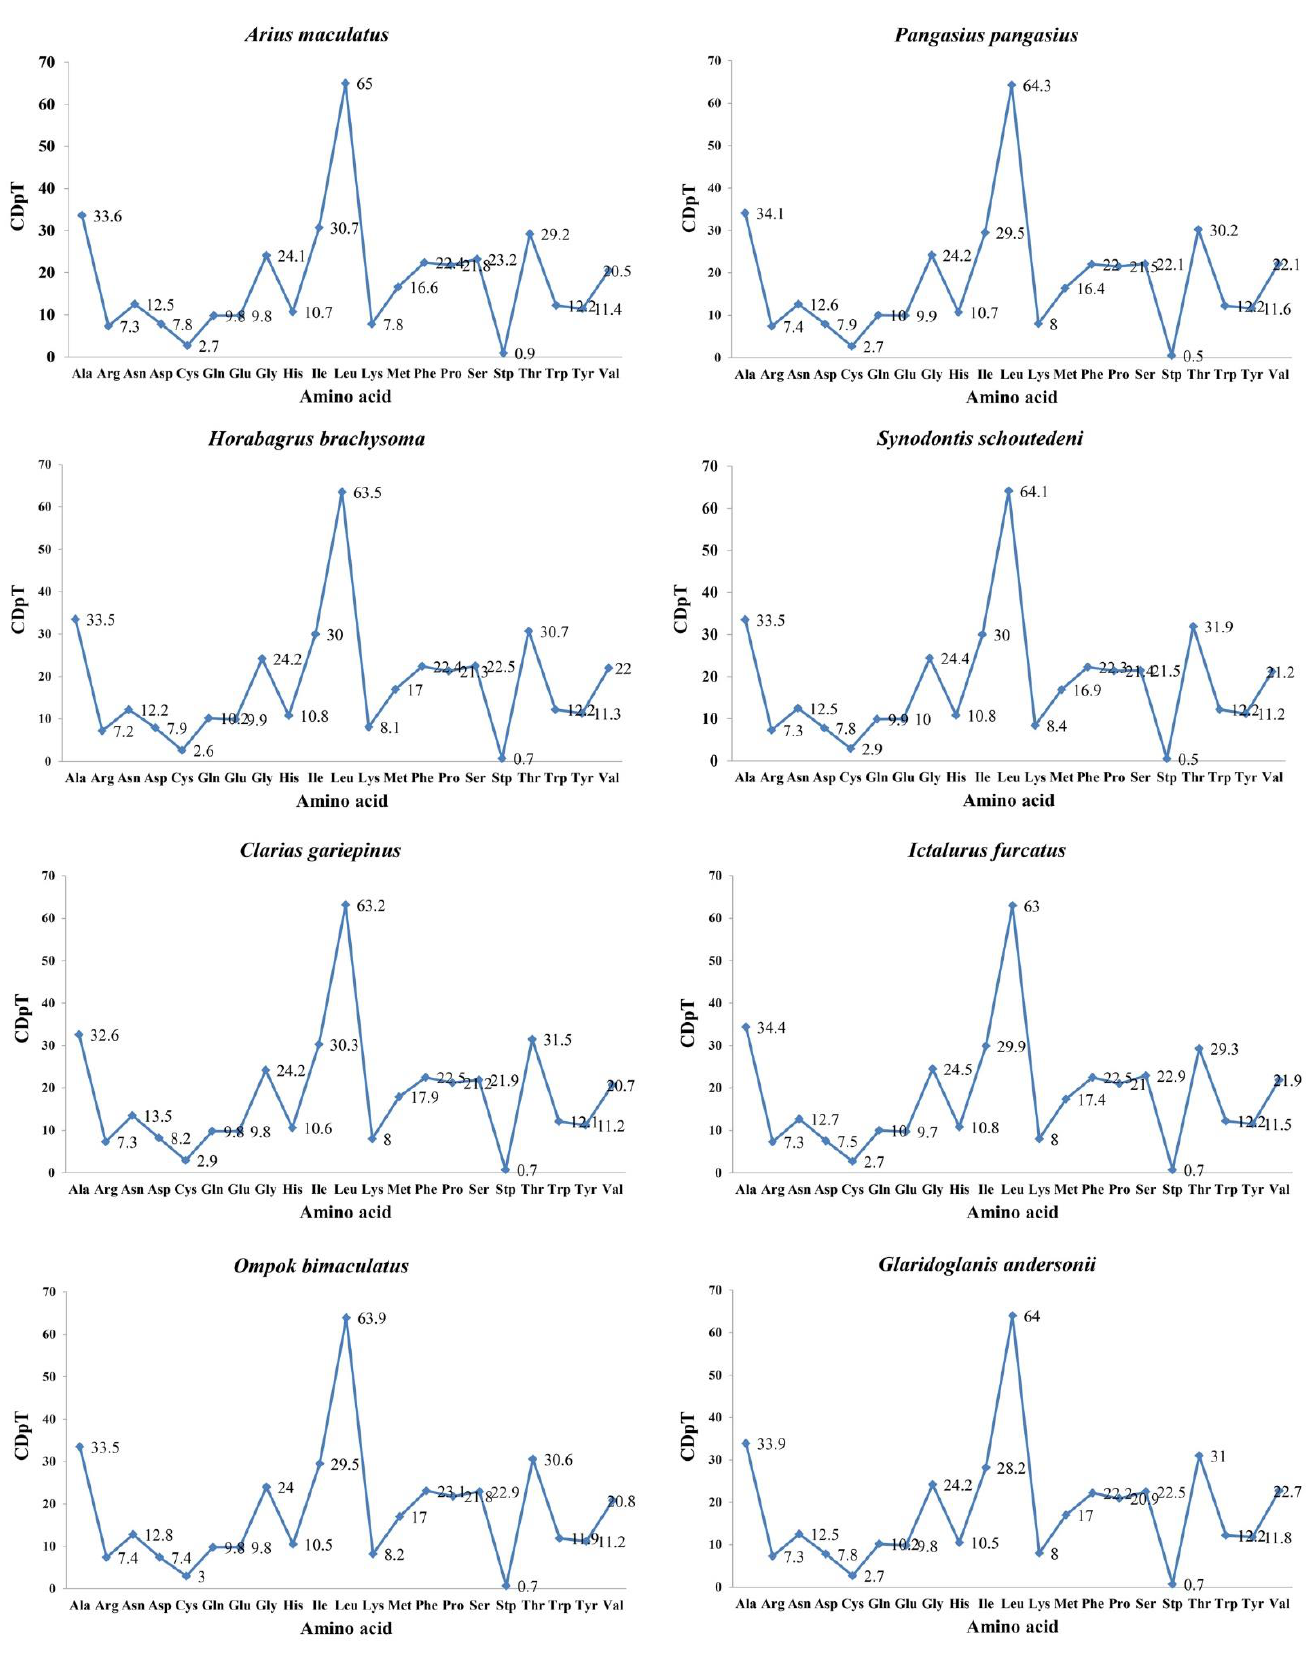
Figure 3. Codon distribution in members of eight superfamilies in the Siluriformes. CDspT = codons per thousand codons.